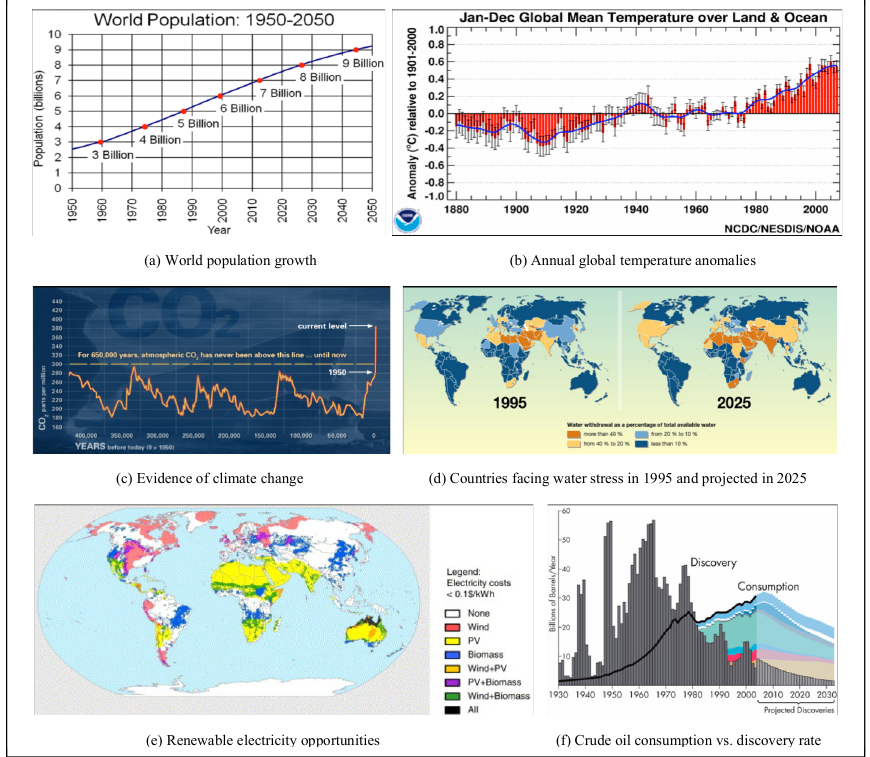
Fig. 2. Sustainability concepts introduced in the course using statistical data